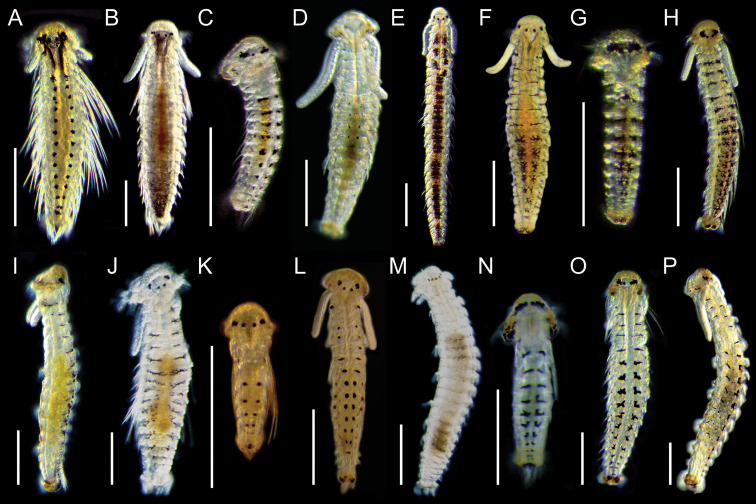
Light micrographs showing the morphologies of living spionid larvae of the genus PolydoraA, BPolydora
brevipalpa, dorsal view of 15‐chaetiger (A) and 17‐chaetiger larvae (B) C, DPolydora
cornuta, dorsolateral view of 11‐chaetiger larva (C) and ventral view of 17‐chaetiger larva (D) EPolydora
cf.
glycymerica, dorsal view of 25‐chaetiger larva FPolydora
hoplura, dorsal view of 15‐chaetiger larva G–IPolydora
onagawaensis, dorsal view of 10‐chaetiger (G) and 18‐chaetiger larvae (H), and lateral view of 16‐chaetiger larva (I) JPolydora
cf.
spongicola, dorsal view of 17‐chaetiger larva K, LPolydora sp. 1, dorsal view of 7‐chaetiger (K) and 16‐chaetiger larvae (L) MPolydora sp. 2, dorsal view of 23‐chaetiger larva N–PPolydora sp. 3, dorsal view of 13‐chaetiger (N) and dorsal (O) and lateral view (P) of 18‐chaetiger larvae. Scale bars: 300 μm.